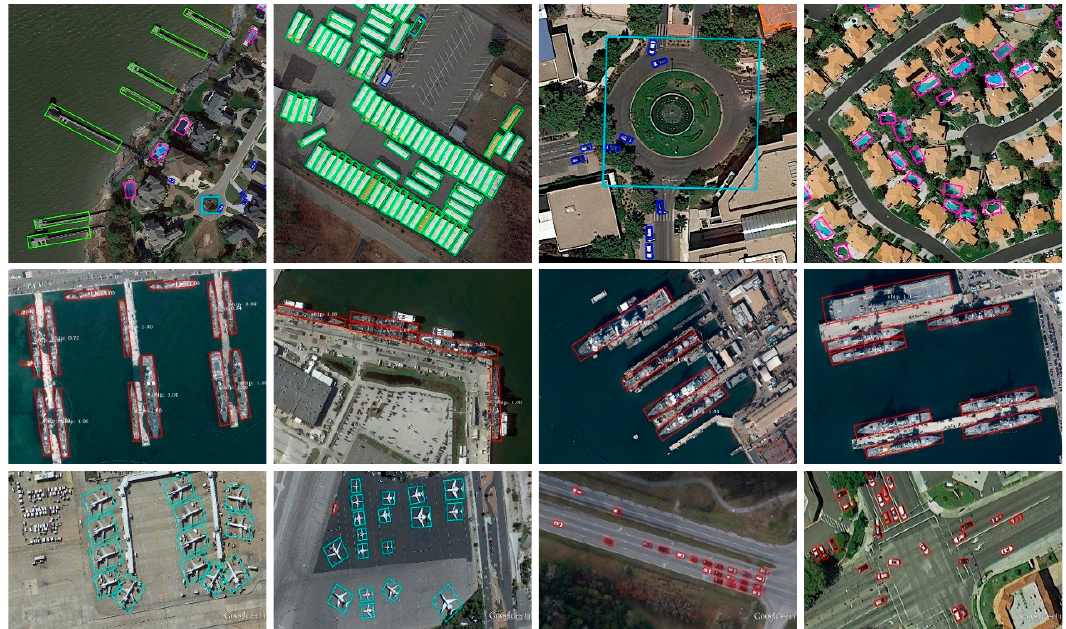
Figure 6. Example detection results of our method. The top row is from DOTA, the middle row is from HRSC2016 and the bottom row is from UCAS-AOD.